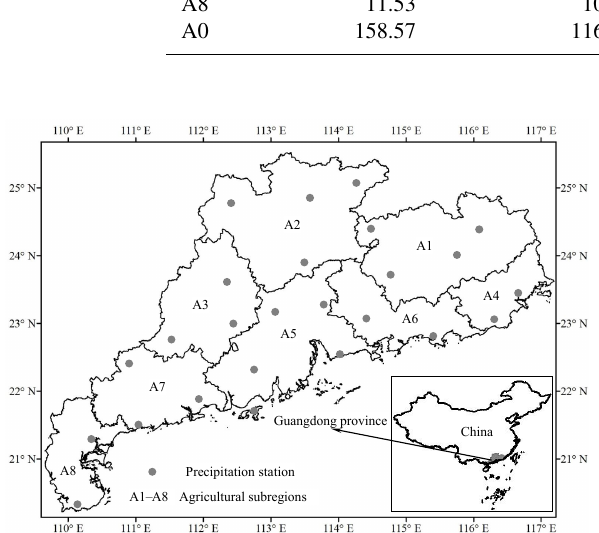
Figure 1. Location of the study region, agricultural sub-regions and precipitation